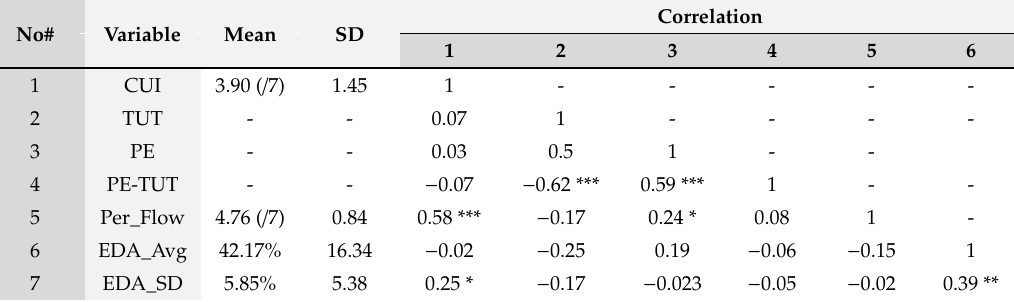
Table 2. Correlation Matrix.